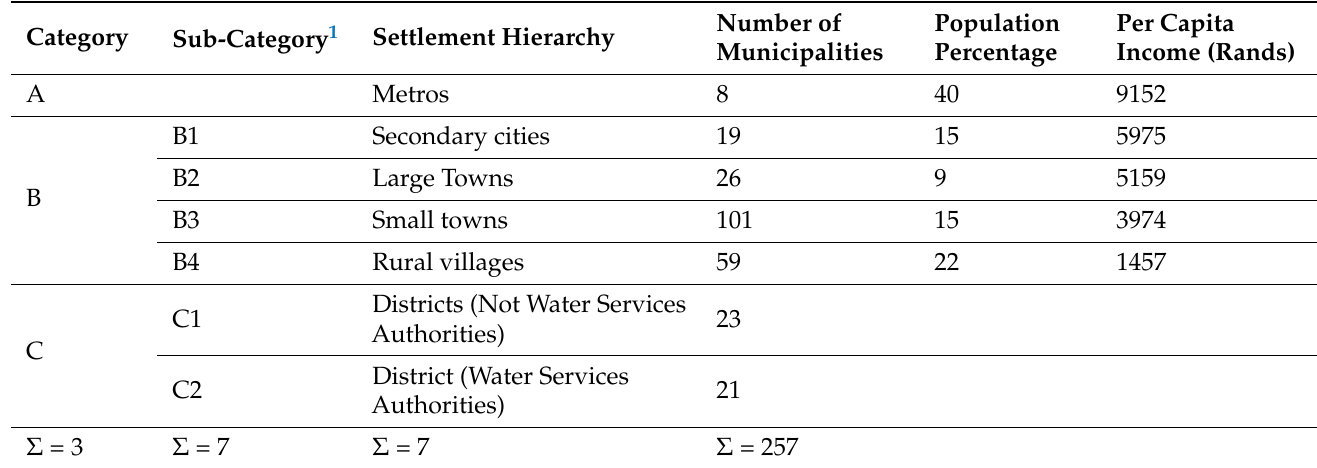
Table 1. Different municipal categories in South